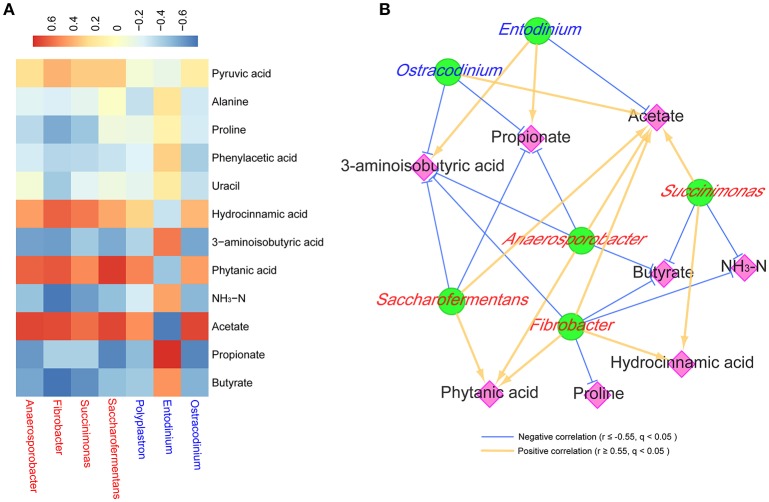
Correlations between the predominant ruminal microbiota affected by treatments and the potential marker compounds. Only the significantly affected ruminal microbiota (at the genera level) that had a mean relative abundance >0.5% were considered in the correlation. Only the ruminal metabolites that had VIP > 1.5, q < 0.05, similarity > 600, and fold change >2 or <0.5 were considered in the correlation. Bacteria are shown by red text color, and protozoa are shown by blue text color. (A) Correlation between the microbiota and metabolites. Cells are colored based on Spearman's correlation coefficient: red represents a positive correlation, and blue represents a negative correlation. (B) Co-occurrence network analysis among the microbiota and metabolites. Each co-occurring pair among microbial populations at the genus level and metabolites has an absolute Spearman rank correlation above 0.55 [gold line, positive correlation (r ≥ 0.55); blue line, negative correlation (r ≤ −0.55)] with a FDR-corrected significance level under 0.05. Microbes are shown by green round nodes, and metabolites are shown by pink diamond nodes.